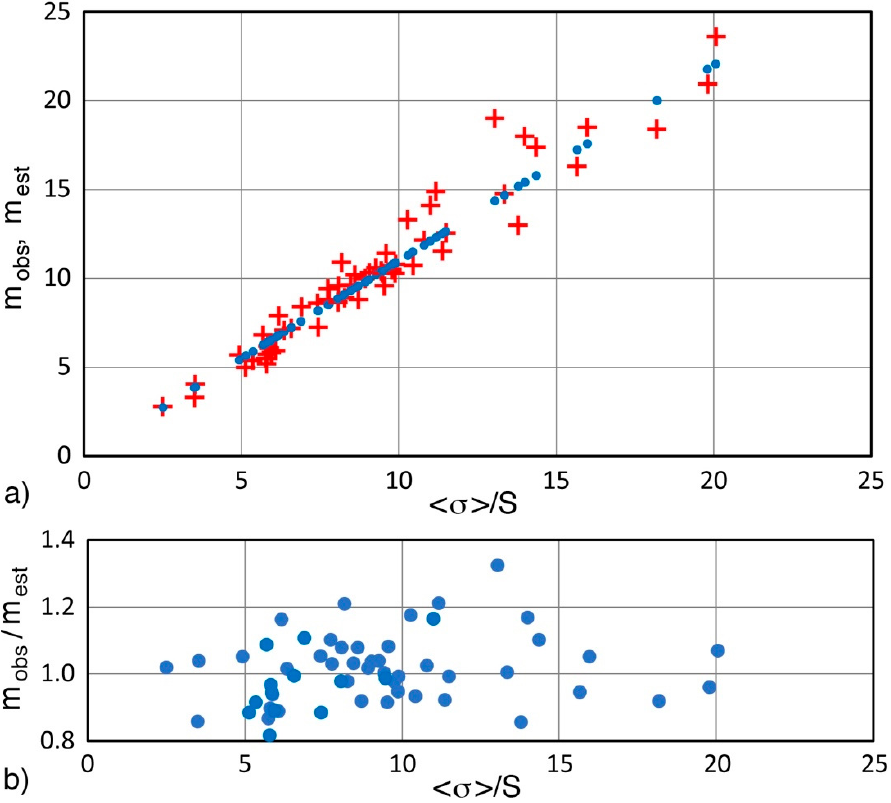
Figure 6. ( a ) Plots of m obs (red + symbol) and m est (blue dot) vs. < σ >/ S for the data of ceramics and glasses. ( b ) Plot of m obs / m est (blue dot) vs. < σ >/ S for the same.